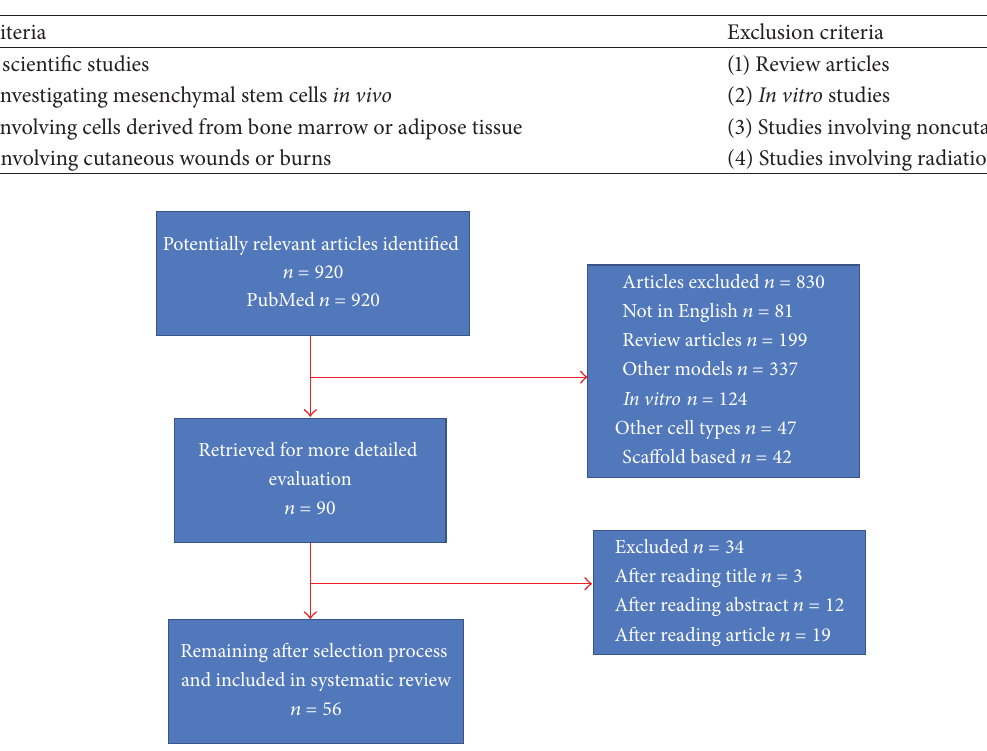
Table 1: Exclusion/inclusion criteria.